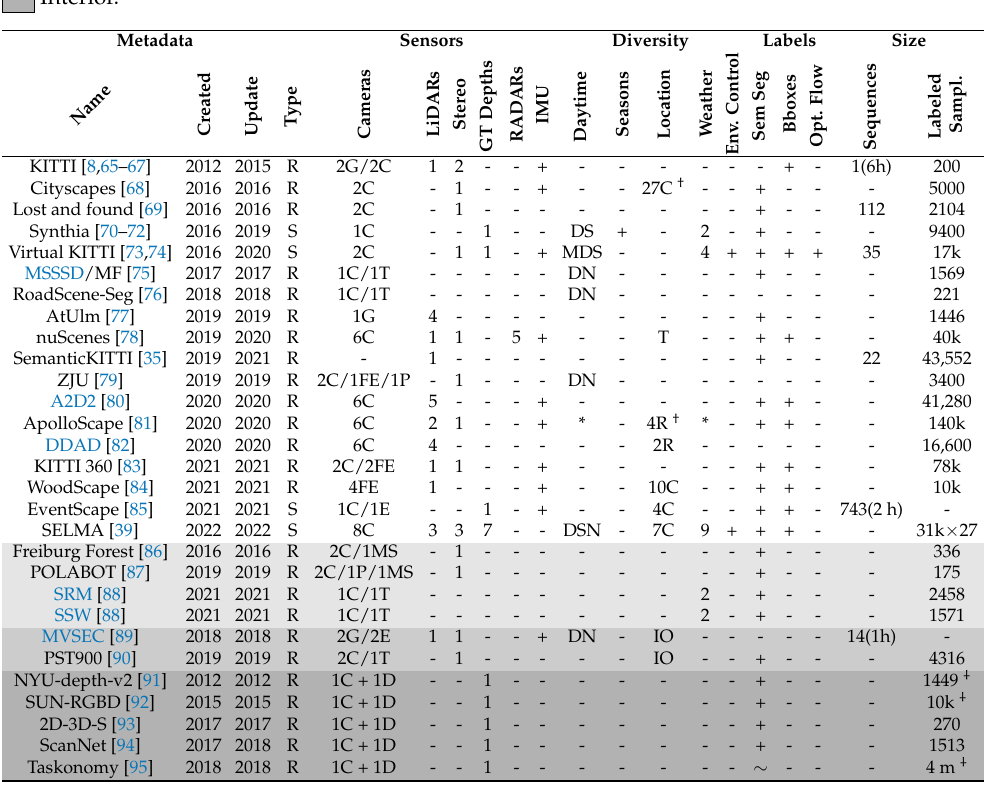
Table 2. Comparison between multi-modal datasets. Shorthand notation used: Type Real/Synthetic; Cameras Grayscale/Color/FishEye/Thermal/Polarization/Event/MultiSpectral/Depth; Daytime Morning/Day/Sunset/Night; Location City/Indoor/Outdoor/Region/Traffic (left/right-handed), † indicates that the cities/regions considered belong to the same state, † indicates that single views of the 3D scene are labeled, ∗ indicates variability with no control or categorization. The table is color-coded to indicate the scenarios present in each dataset: Driving, Exterior, In/Out, Interior. Metadata Sensors Diversity Labels